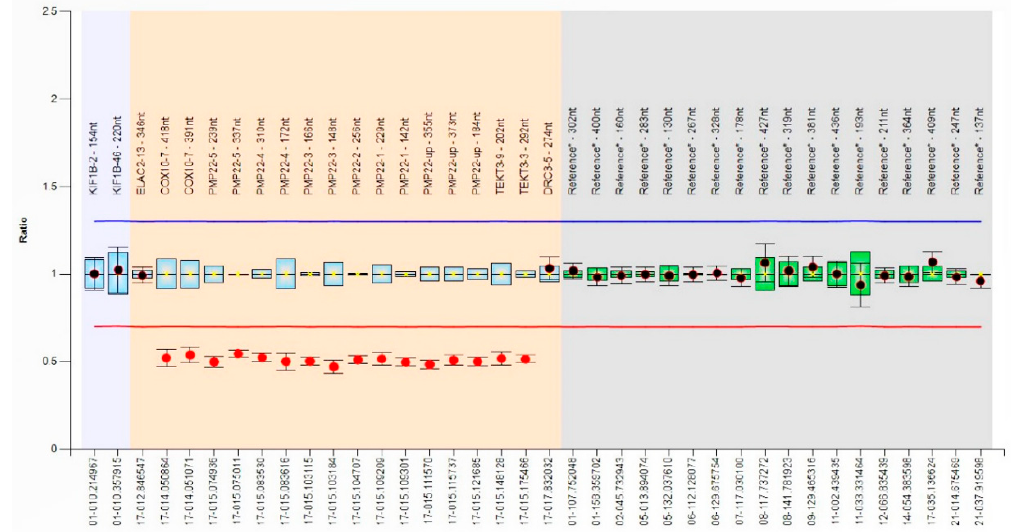
Figure 1. MLPA results of samples with contiguous gene deletion of chromosome 17p11.2 that included COX10 , PMP22 , and TEKT3 in the bar chart generated using Coffalyser.Net. The x- and y- axes indicate the names of each MLPA probe and the peak ratio, respectively. The reference probe area is colored in gray. Deletions or duplications can be identified when the peak ratio was <0.65 (red line) or >1.3 (blue line), respectively. Exons with a reduced peak ratio (heterozygous deletion, between 0.40 and 0.65) are indicated with a red dot.